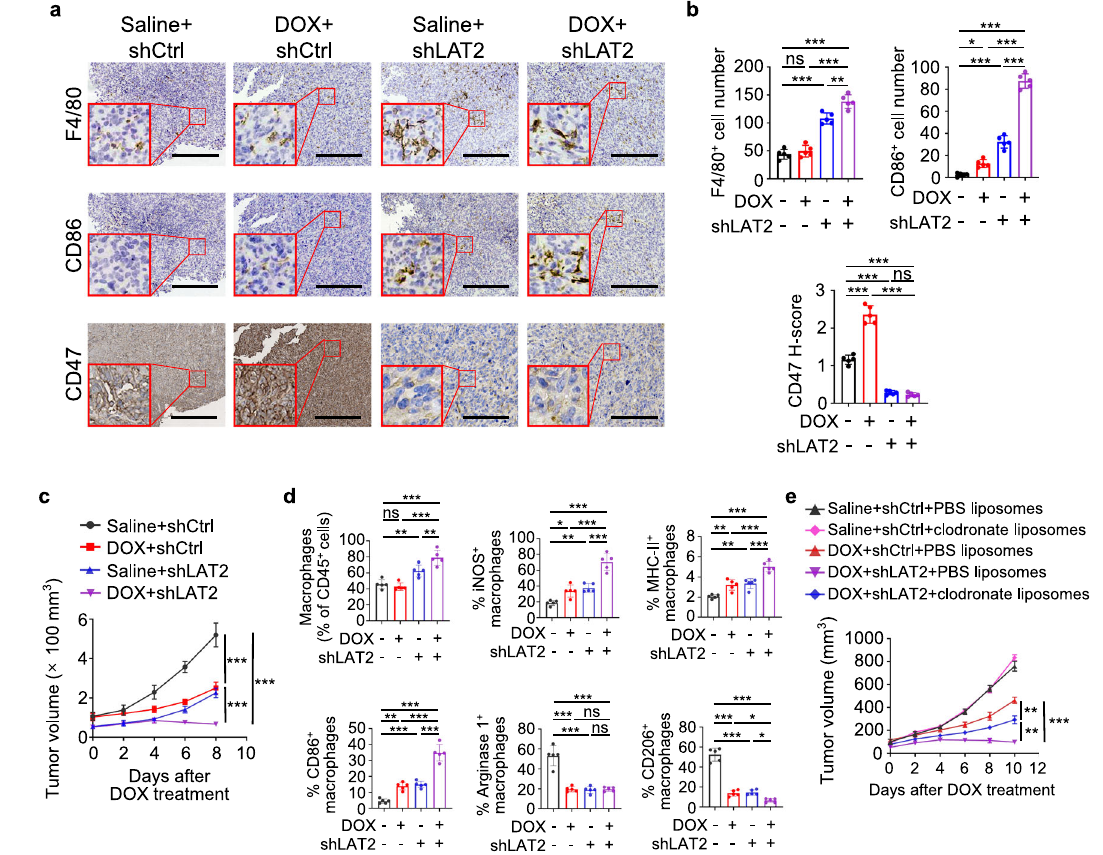
Fig. 9 | LAT2 depletion sensitizes osteosarcoma to doxorubicin treatment. a – d Miceweretreatedwithsalineordoxorubicin(DOX)everyotherdayaftershCtrl or shLAT2 HOS tumors grew for 14 days. a Representative immunohistochemical images stained with F4/80, CD86, or CD47 antibodies in serial sections of tumors on day 22. Scale bar, 150 μ m. b Statistical analyses of IHC quanti fi cation results for samples depicted in ( a ) ( n =5 mice per group). c Measurement of tumor growth in mice ( n =5 mice per group). Tumor volume was measured at the indicated time points. d Flow cytometric analysis of MHC-II, iNOS, CD86, Arginase 1, and CD206